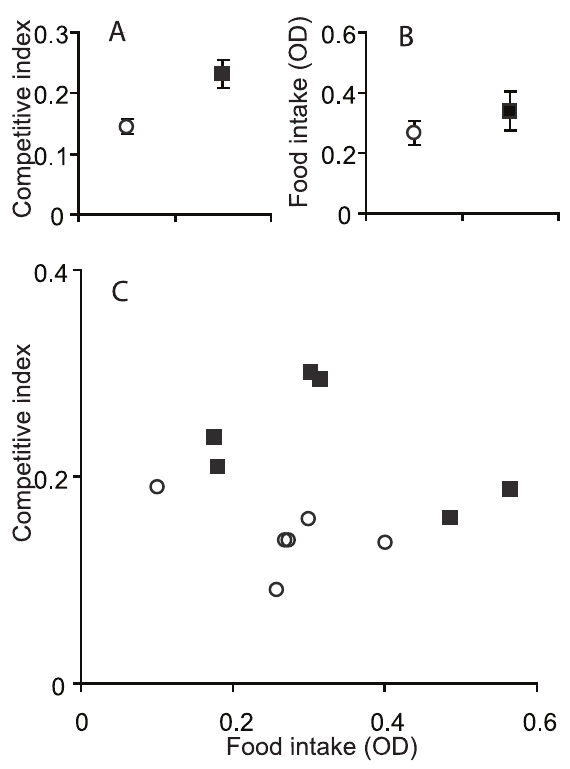
Figure 1. Larval competitive ability and feeding rate of the selected (squares) and control (circles) populations. (A) Mean competitive index and (B) mean food intake for each regime (bars indicate 6 one standard error based on variation among populations). (C) Correlation plot of estimates of the two variables for each replicate